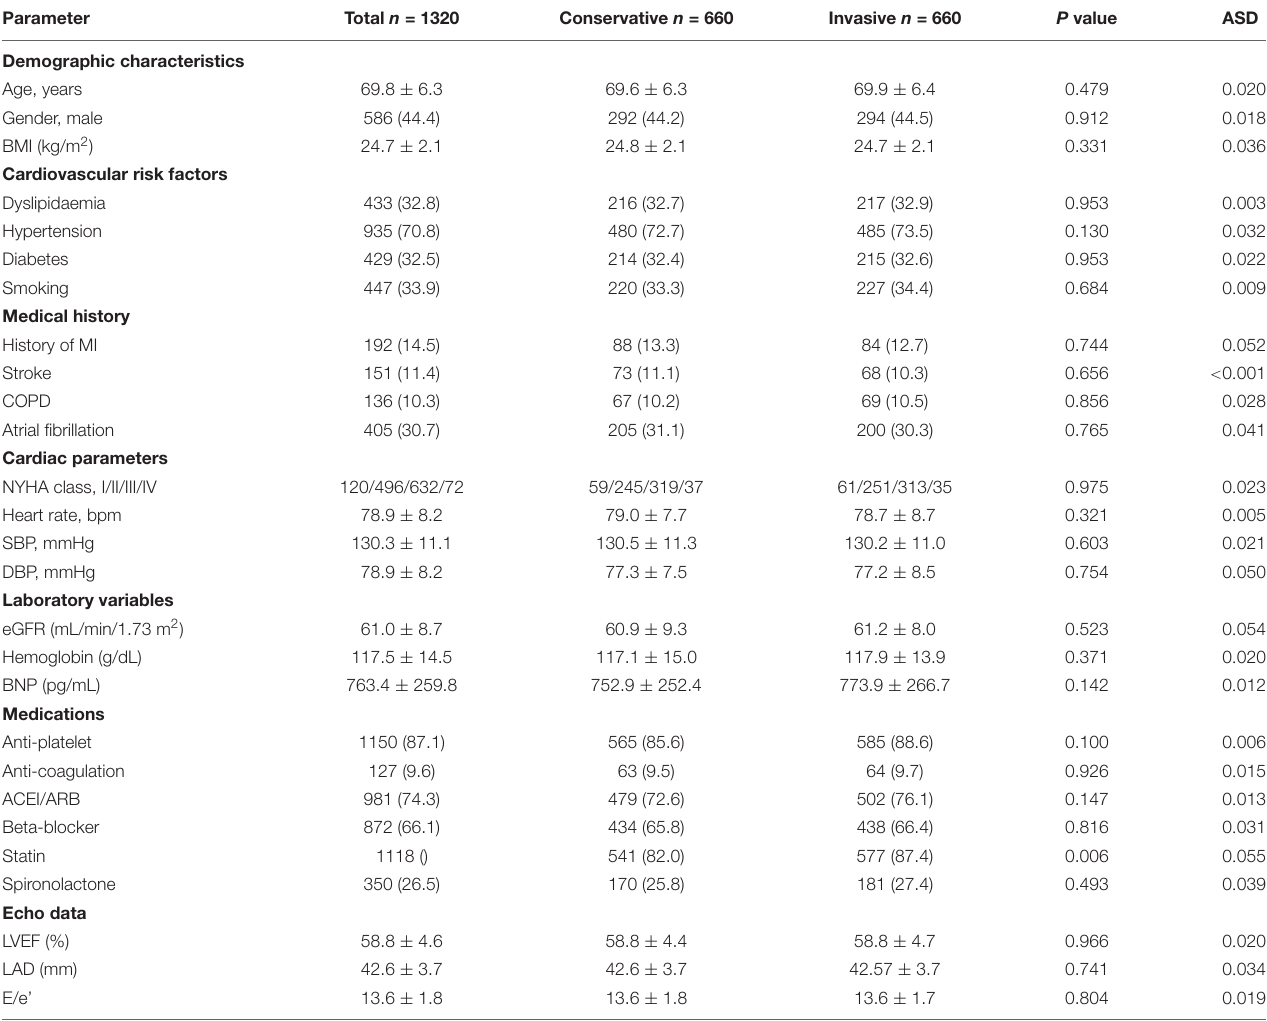
TABLE 2 | Baseline clinical characteristics and medications after propensity score matching. Parameter Total n = 1320 Conservative n = 660 Invasive n = 660 P